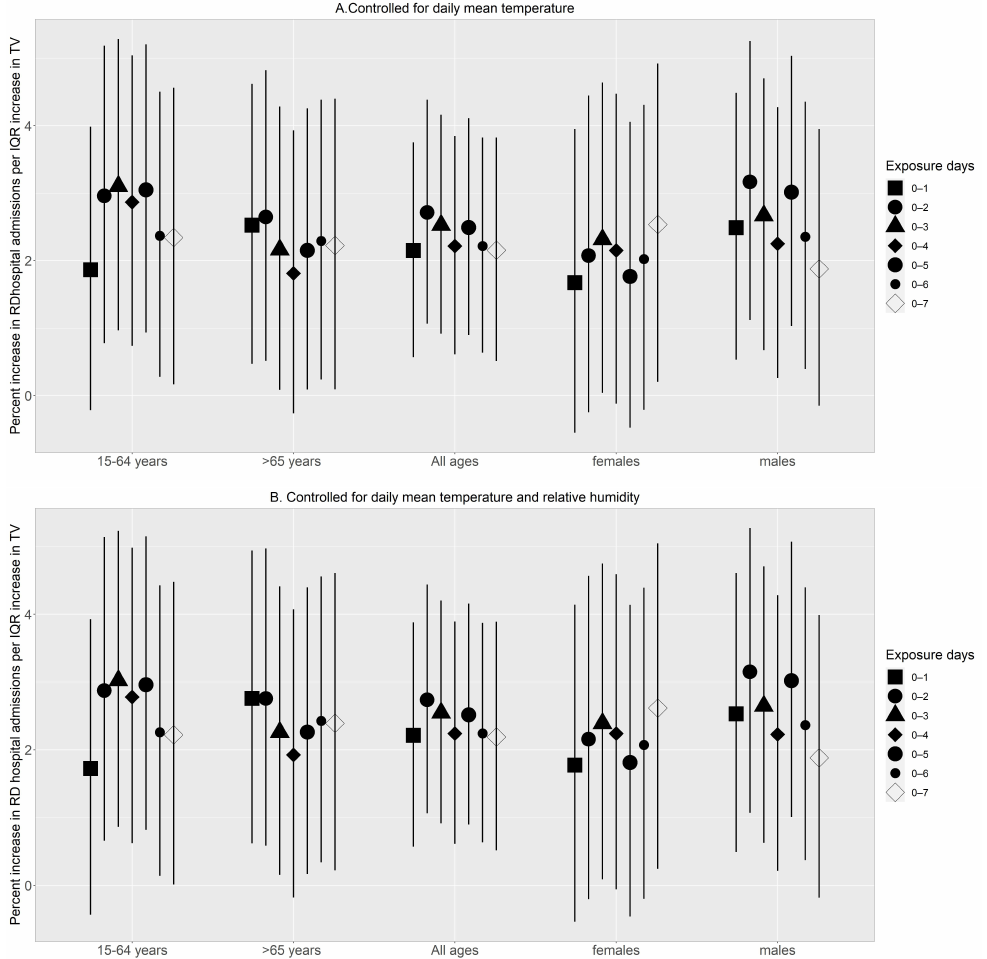
Figure 3. Percent change (95% confidence interval) in cardiovascular disease hospitalisation as- sociated with an interquartile increase in temperature variability (°C) on different exposure days: ( A ) After controlling for the day of the week, time, and seasonal trends and daily mean temperature. ( B ) After controlling for the day of the week, time, and seasonal trends and daily mean temperature and relative